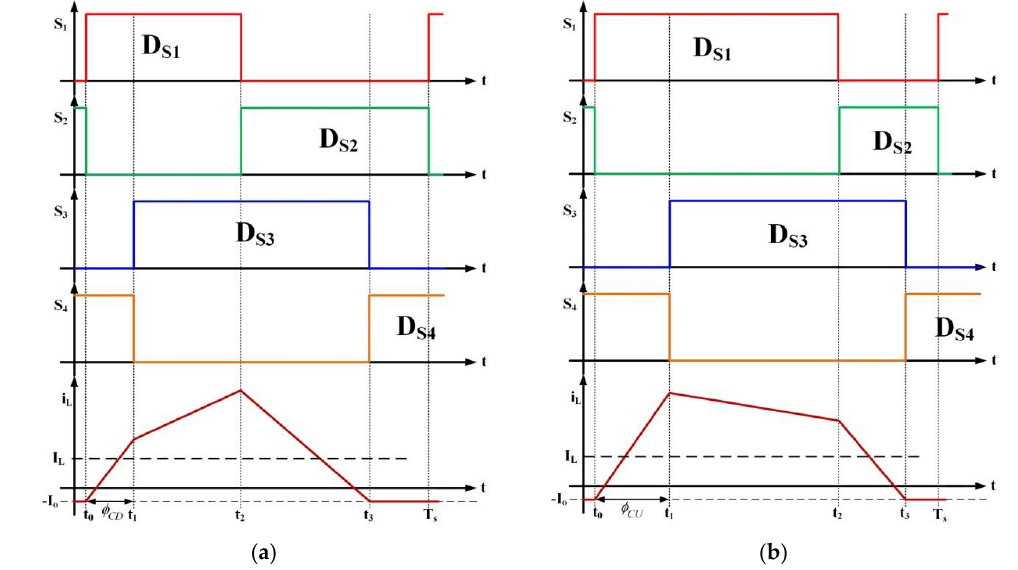
Figure 2. The gating signals and inductor current waveforms during charging operation. ( a ) Buck mode; ( b ) Boost mode.